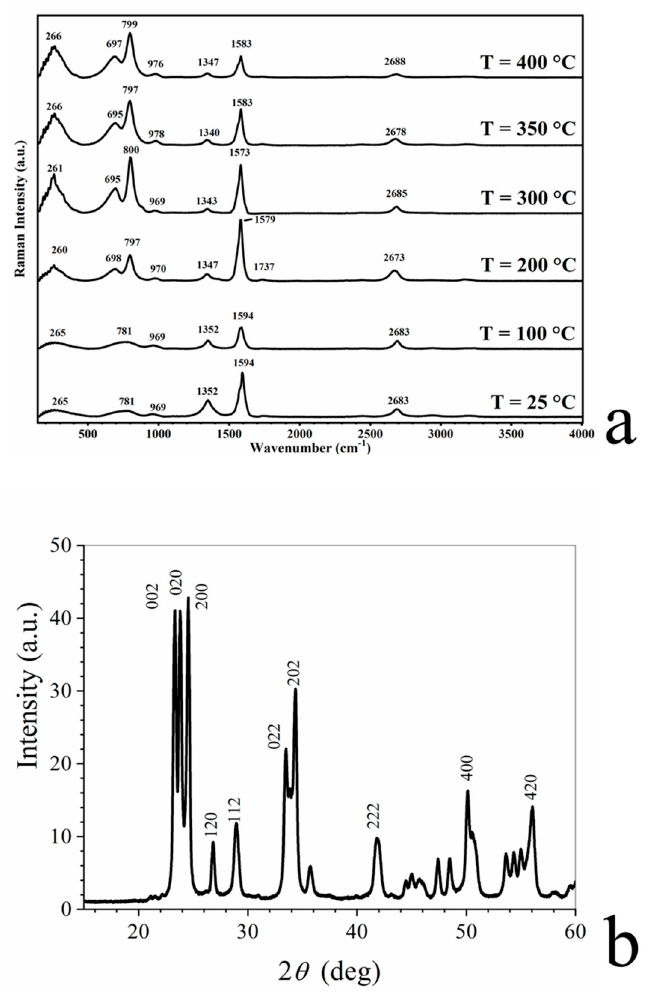
Figure 7. ( a ) Thermal evolution of Raman spectrum of WO 3 deposited onto BP membranes. The peaks at around 700 and 800 cm − 1 are assigned to WO stretching ( ν ), WO bending ( δ ), and OWO deformation ( γ ) modes, respectively, confirming the monoclinic structure of WO 3 ; ( b ) X-ray di ff raction patterns of WO 3 layer sputtered onto BP membranes. Peaks are related to the reflection planes of the monoclinic phase of WO 3 .